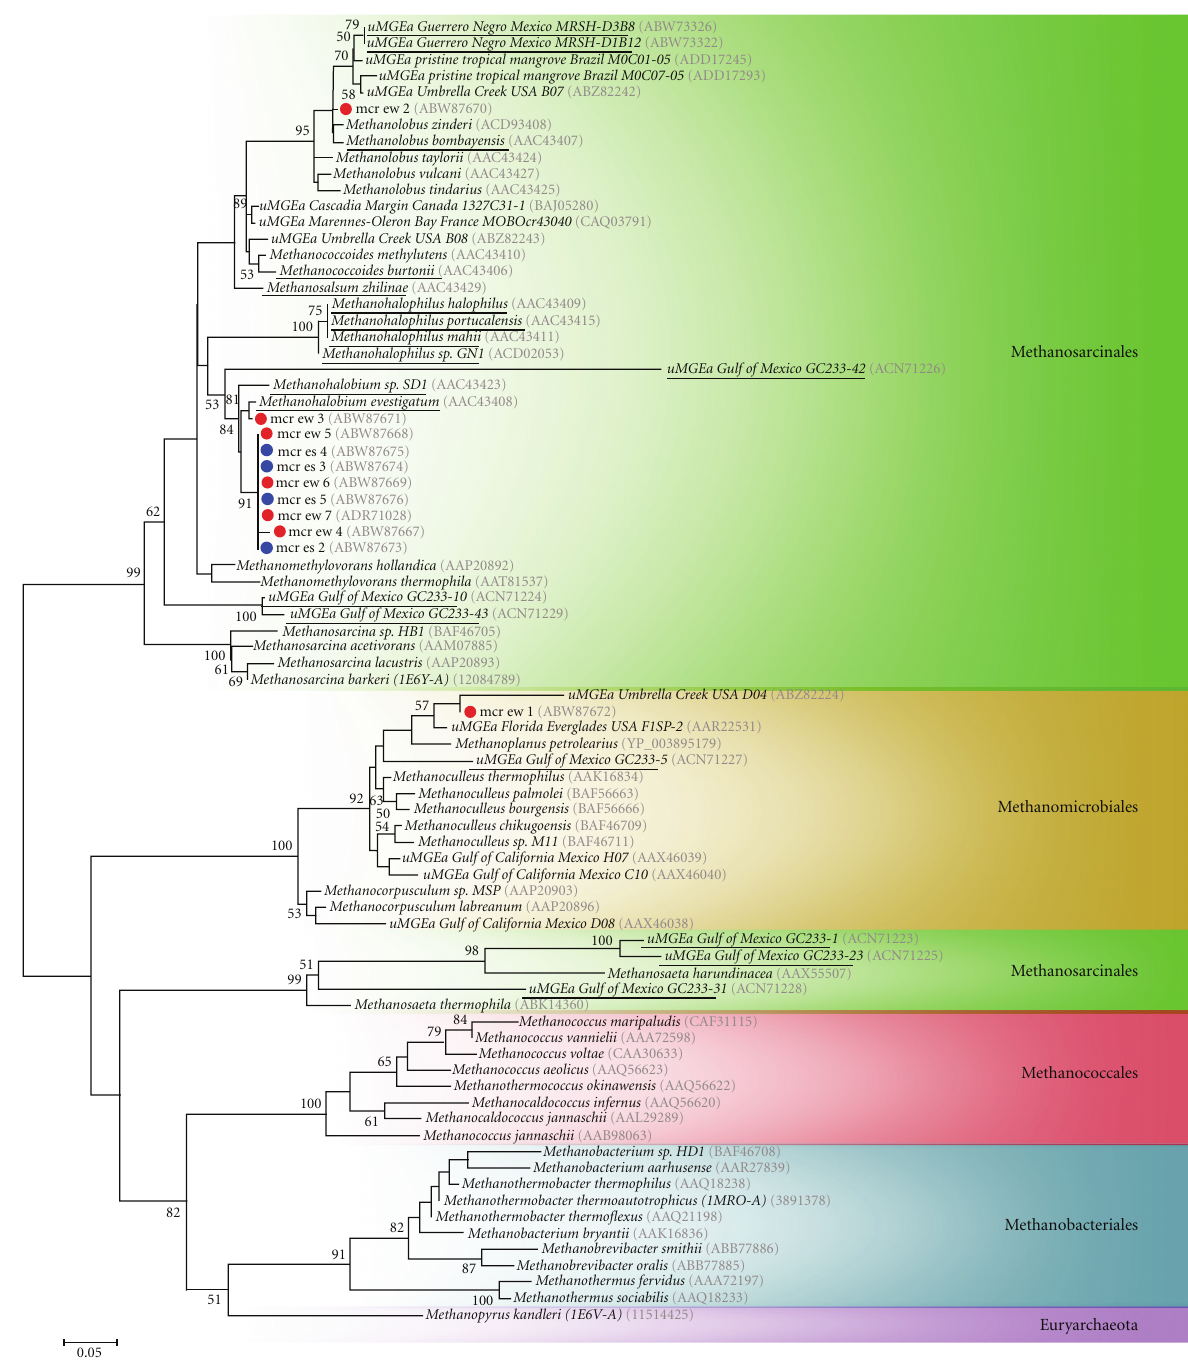
Figure 6: The phylogenetic tree is showing the relationship of McrA from Tirez sediments with McrA sequences of characterized MA (supplementary material, Table S2). The blue circle identifies the summer phylotypes, and red circle is for the winter phylotypes. Halophilic known species are underlined. The scale bar represents 0 ± 1 substitutions per aa position. Percentages ≥ 50% of bootstrap are indicated near the nodes. See Section 2 to observe details of the phylogenetic reconstruction done for this